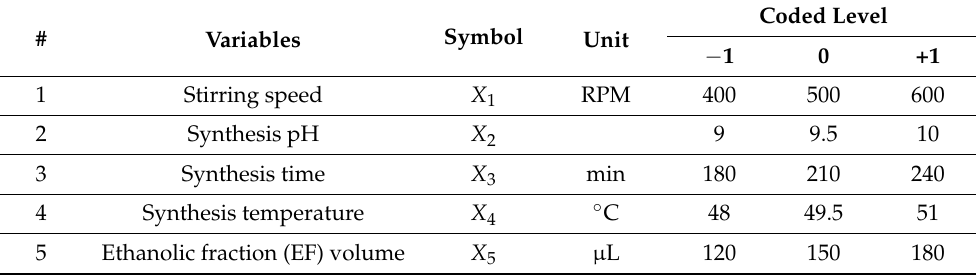
Table 2. Levels of the variables tested in the central composite design (CCD) for AgNPs